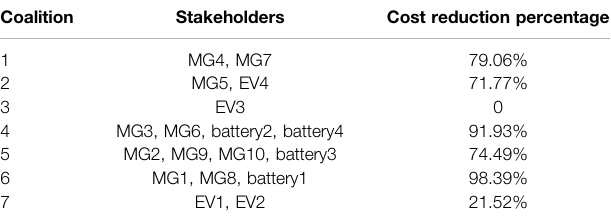
TABLE 4 | The results of coalition and cost reduction percentage.